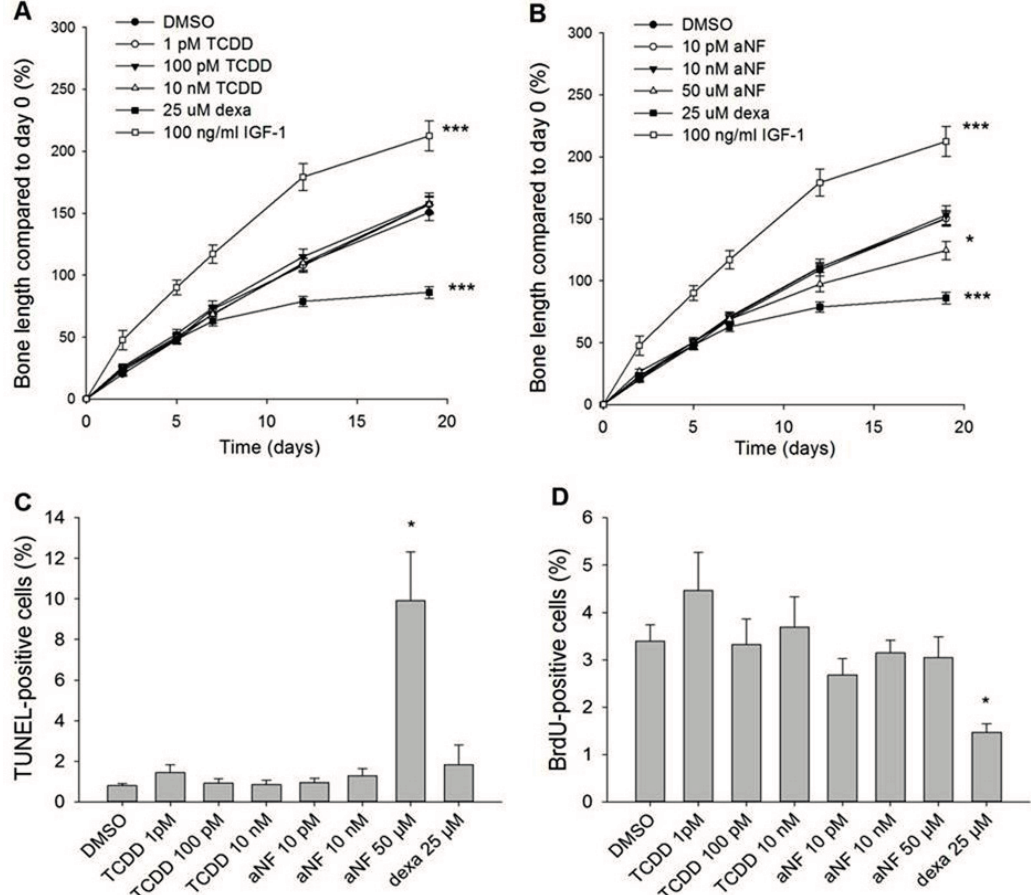
Figure 3. Growth curves of fetal rat metatarsal bones cultured and treated for 19 days with either the agonist TCDD ( A ) or the antagonist α NF ( B ), n = 10–12. Percentages of apoptotic chondrocytes detected with TUNEL-staining ( C ) and of proliferating chondrocytes detected with BrdU-incorporation analysis ( D ) in the cultured bones, n = 3–6. Data are presented as the mean ± SEM. * p < 0.05; *** p <